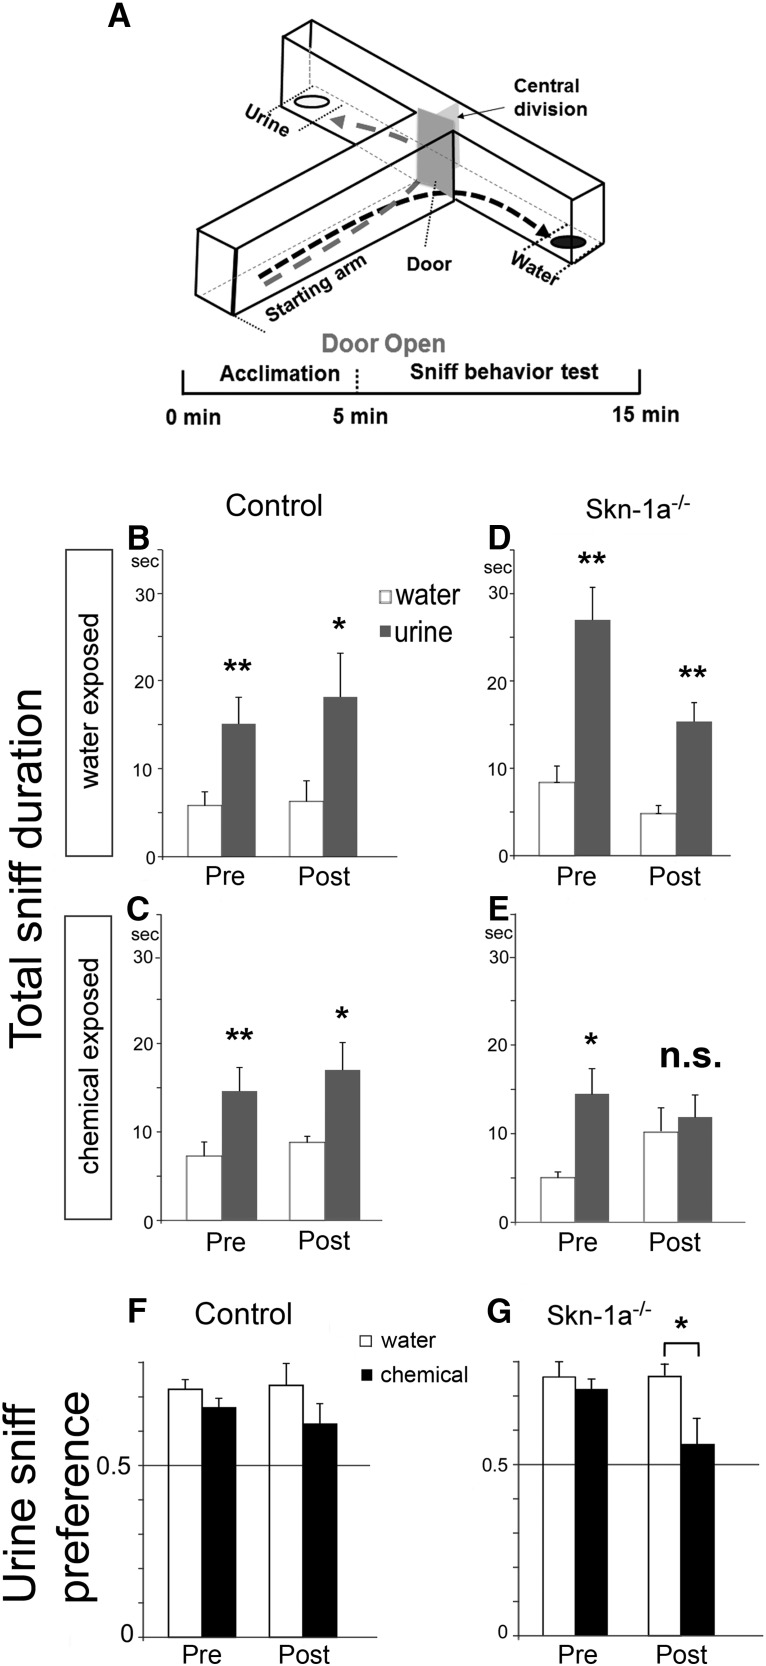
Olfactory preference toward urine of the opposite sex is compromised in chemical-exposed Skn-1a-/- mice. A, Schematic drawing of the T-maze apparatus used to test olfactory preference for urine. A single mouse was placed in the starting arm of the T-maze for a 5-min acclimation period before the gate was opened, which allowed the mouse to enter either arm. B–E, Plots of total sniff duration. Both control and Skn-1a-/- male mice displayed a strong preference for the female urine samples before exposure (*, p < 0.05, **, p < 0.01, paired t test, n = 5–8). Control mice retained their strong preference for urine samples after exposure to either water or chemicals (*, p < 0.05, **, p < 0.01, paired t test, n = 5–8). In contrast, only the water-exposed Skn-1a-/- mice maintained the strong preference (**, p < 0.01, paired t test, n = 6). Chemical-exposed Skn-1a-/- mice no longer significantly preferred urine over water (p = 0.316, paired t test, n = 7). F, G, Plots of sniff preference (ratio of urine sniff duration over total sniff duration). No significant difference was found in the control mice pre- and post-exposure (p = 0.113 and 0.120, respectively, t test), or the pre-exposure Skn-1a-/- mice group (p = 0.207, t test). However, a significant reduction was found in Skn-1a-/- mice of chemical-exposed group compared with the water-exposed group (*, p < 0.05, t test).